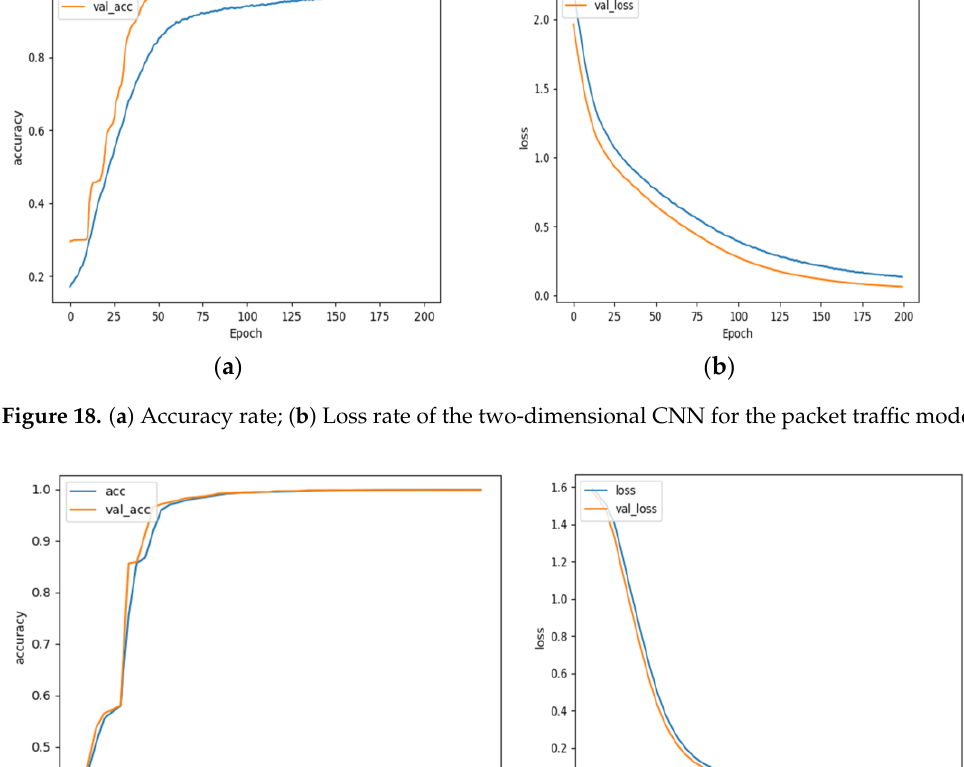
Table 7. Accuracy for NN, 1D CNN, and 2D CNN trained by using packet feature dataset. Model